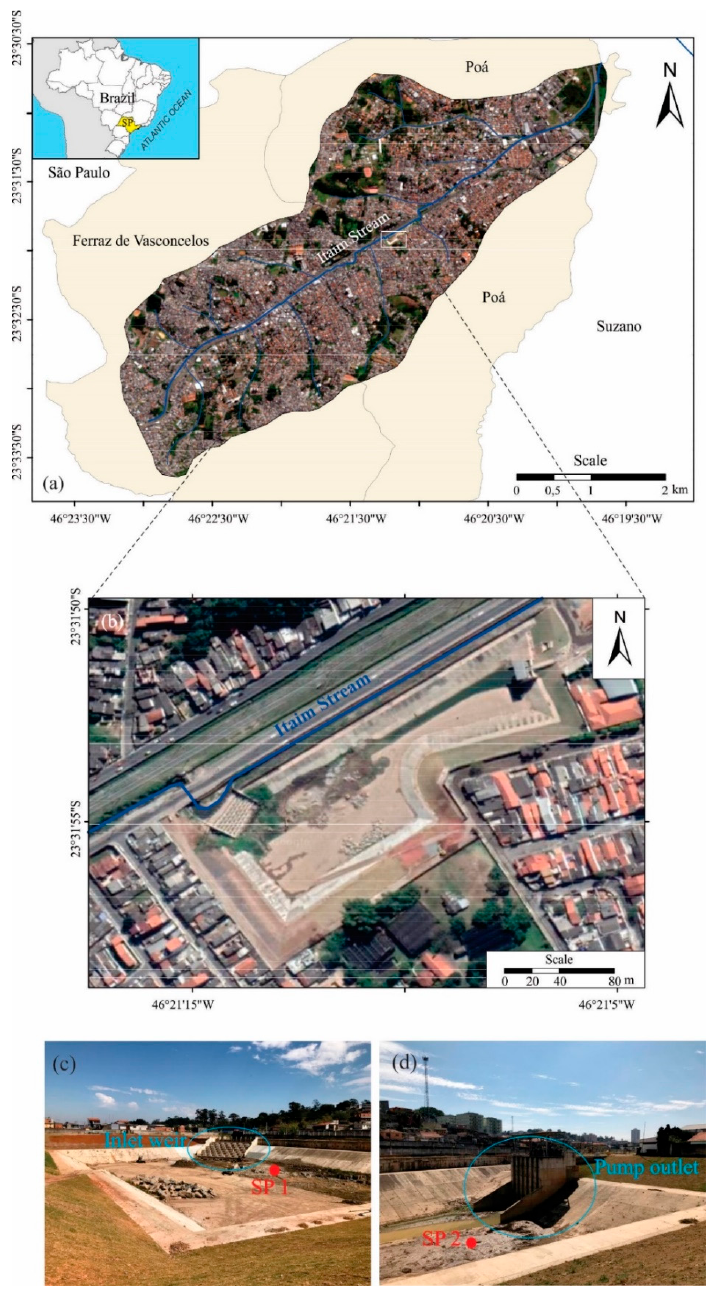
Figure 1. Sampling Area. ( a ) Itaim Stream catchment; ( b ) Po á Stormwater detention reservoir (Piscin ã o da Vila Romana); ( c , d ) Sampling points SP 1 ( c ) and SP 2 ( d